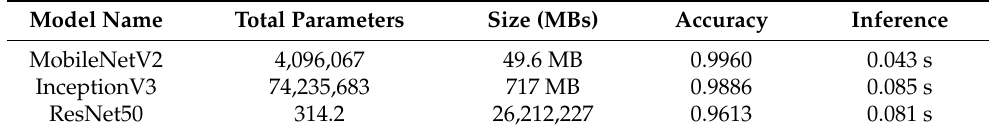
Table 3. MobileNet size and parameters comparison with other pre-trained